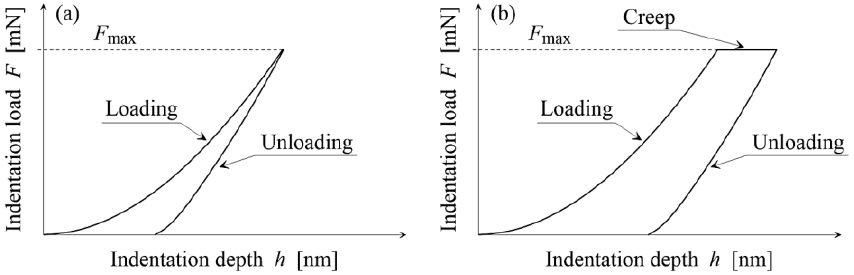
Figure 4. ( a ) Standard indentation curve and ( b ) indentation curve that includes creep.